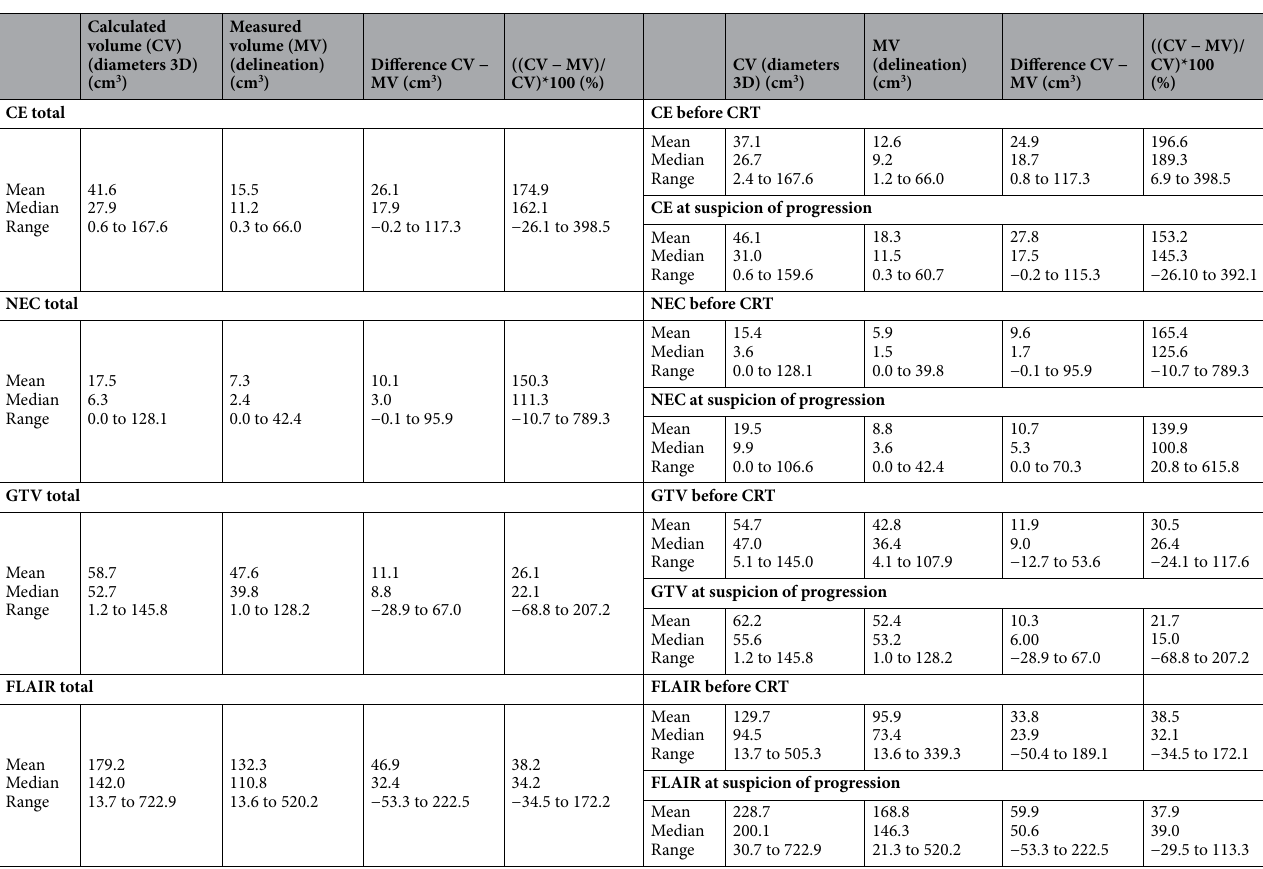
Table 1. Calculated volume and measured volume for the different glioblastoma compartments (114 MRIs). Calculated volume (CV) and measured volume (MV) and difference between the two measurement methods for the CE, the NEC, the GTV, and the FLAIR compartments for the 114 MRIs: the 57 MRIs before CRT and the 57 MRIs showing a suspicion of progression. CE contrast-enhancement, GTV gross target volume, NEC necrosis